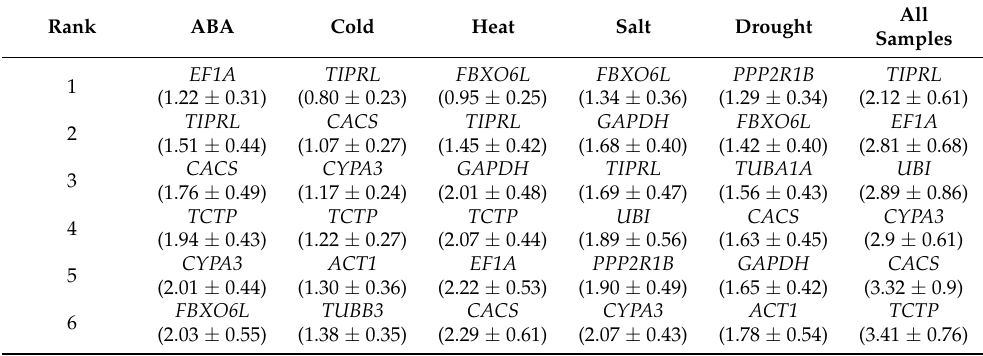
Table 2. Expression stability and ranking of 14 candidate reference genes calculated using BestKeeper. The numbers in brackets represent coefficient of variation (CV) ± standard deviation